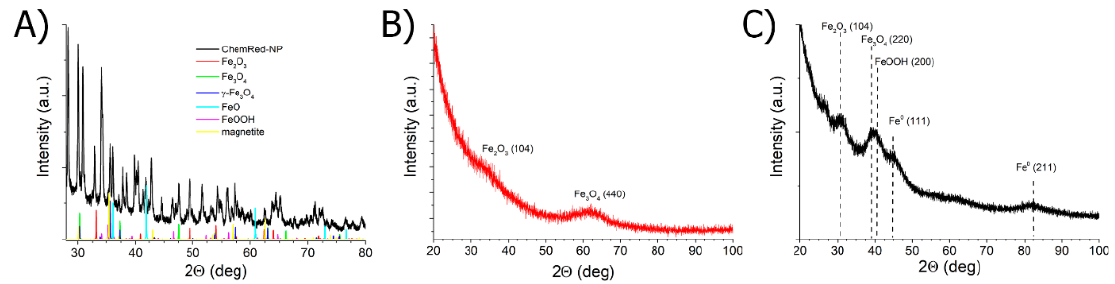
Figure 5. XRD spectra of ( A ) ChemRed-NP; ( B ) US/TermRed-NP; ( C ) US-NP.